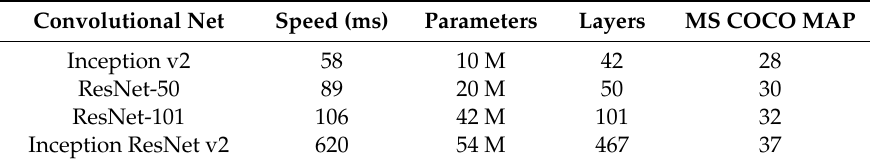
Table 2. List of available pre-trained object detectors in the TensorFlow Object Detection Package. Inference speed, number of parameters of the models in million, the number of layers in the network and the mean-average-precision (MAP) on the standard object-detection benchmark Microsoft Common Objects in Context (MS COCO) are reported. MS COCO numbers are based on the Tensorflow Object Detection Benchmarks. Convolutional Net Speed (ms) Parameters Layers MS COCO MAP Inception v2 58 10